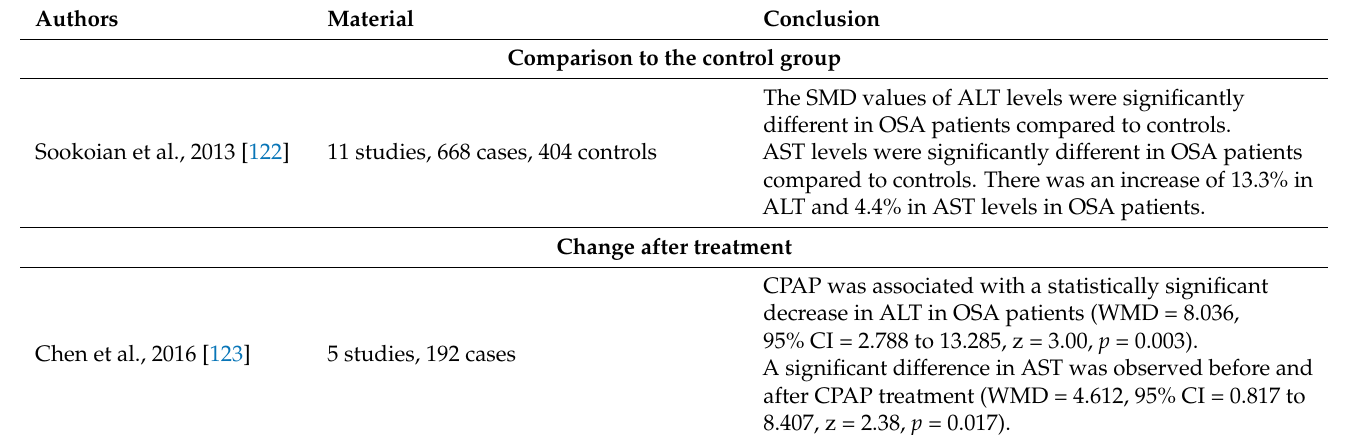
Table 13. Meta-analyses of ALT and AST studies in OSA adults.